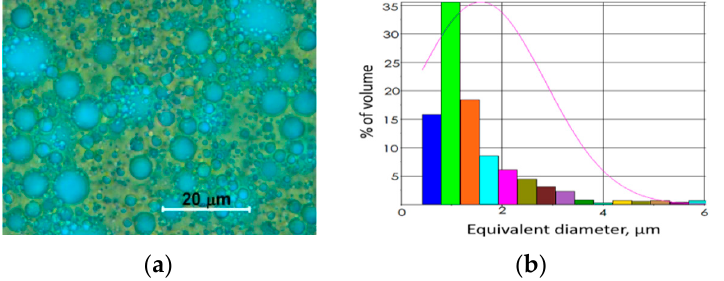
Figure 4. Microphotographs of W/OE (10×) at temperatures: ( a ) 22 °C (1.9 µm); ( b ) 32 °C (3.6 µm); and ( с ) 40 °C (4.7 µm).